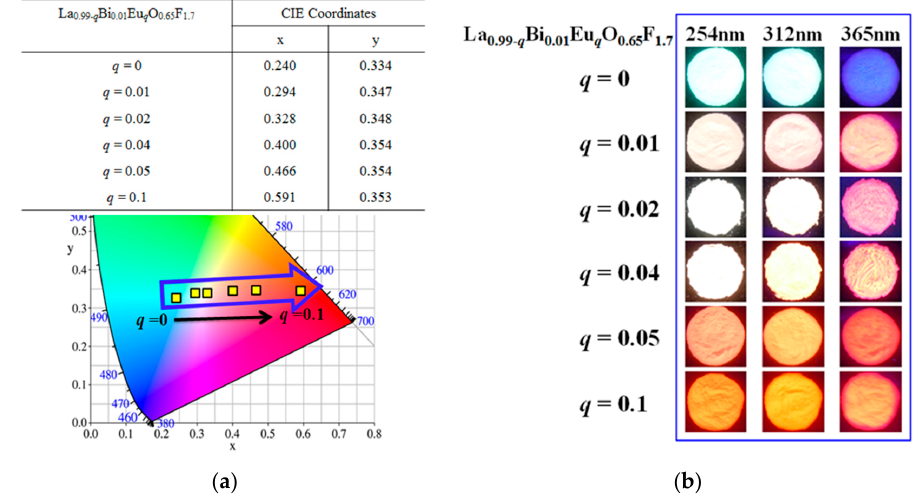
Figure 5. ( a ) The chromaticity coordinates with the desired CIE values of La 0.99- q Bi 0.01 Eu q O 0.65 F 1.7 ( q = 0– 0.1) phosphors ( EX = 286 nm) and ( b ) photographs of the emission light from blue-green to white, orange, and red colors in the La 0.99 − q Bi 0.01 Eu q O 0.65 F 1.7 phosphors under 254, 312, and 365 nm hand- lamps.